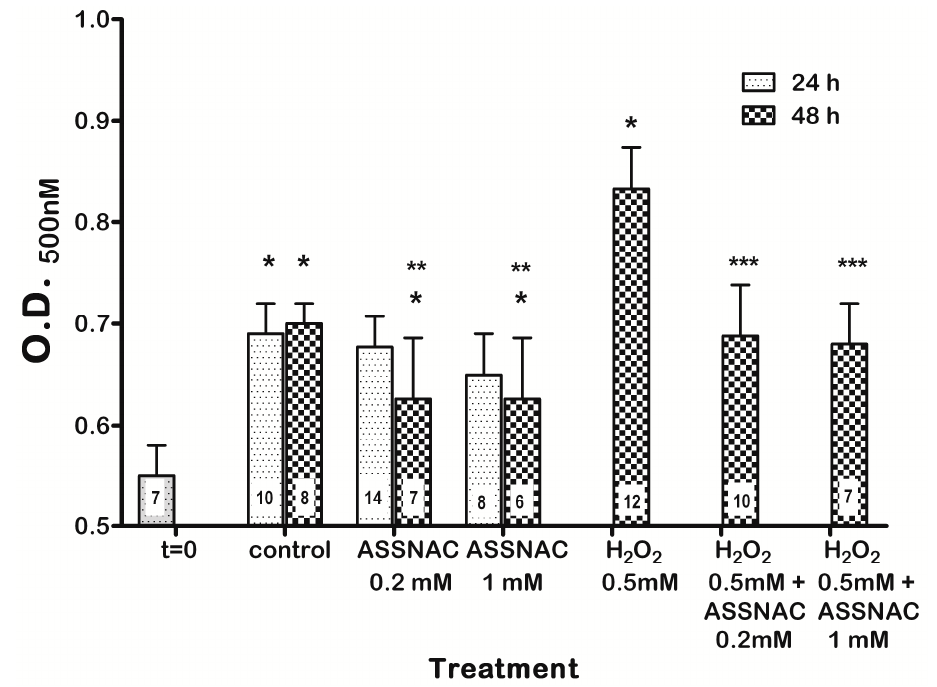
Figure 6. Effect of ASSNAC on lens opacity in an ex-vivo lens cataract model. Lenses opacity was determined on fresh lenses ( t = 0) and on lenses cultured without (control) or with ASSNAC (0.2 or 1.0 mM) for 24 h. In parallel, opacity of control and ASSNAC-treated lenses that were incubated for additional 24 h without or with H 2 O 2 (0.5 mM) was determined. The number of lenses per each treatment is indicated in each bar. Significant differences were marked: * p ≤ 0.05 versus t = 0; ** p < 0.05 versus control group; *** p < 0.05 versus H 2 O 2 group.